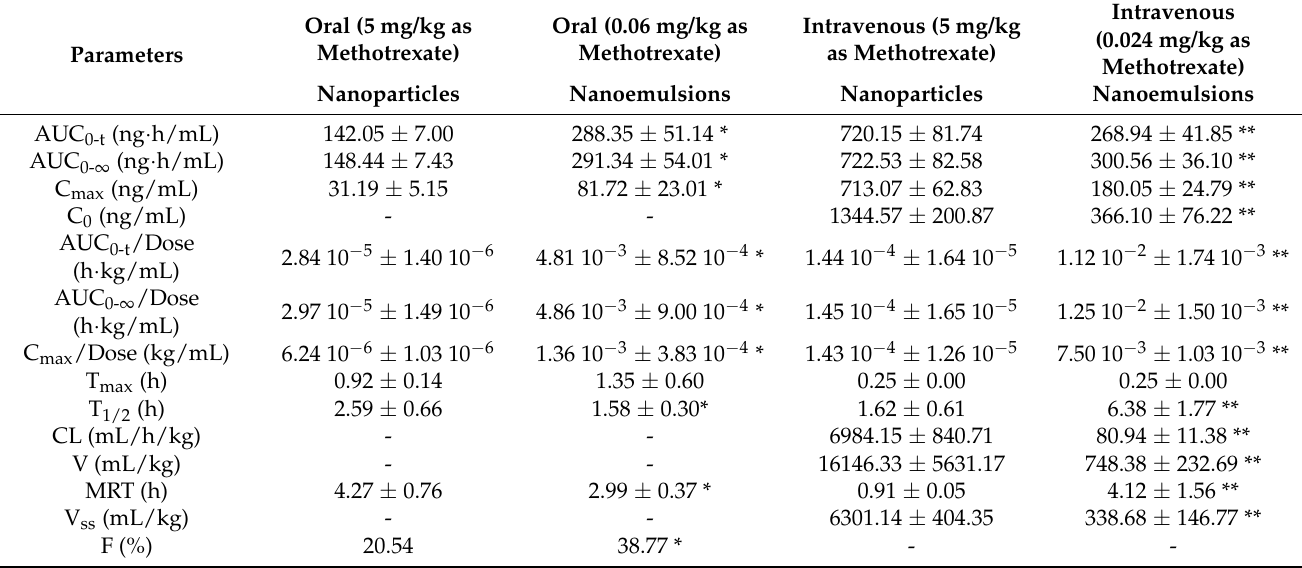
Table 6. Comparison of estimated pharmacokinetic parameters of methotrexate-loaded nanoformulations after a single dose to rats ( n = 5) by non-compartmental